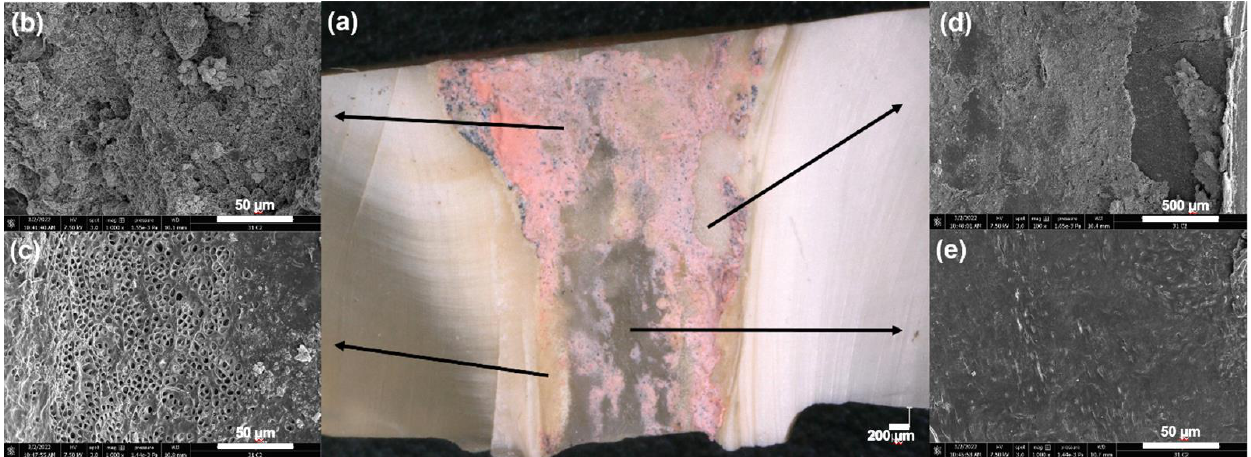
Figure 3. Scanning electron microscope micrographs showing the different observed colors and structures of the root canal and residual materials, which were detected under a digital microscope.